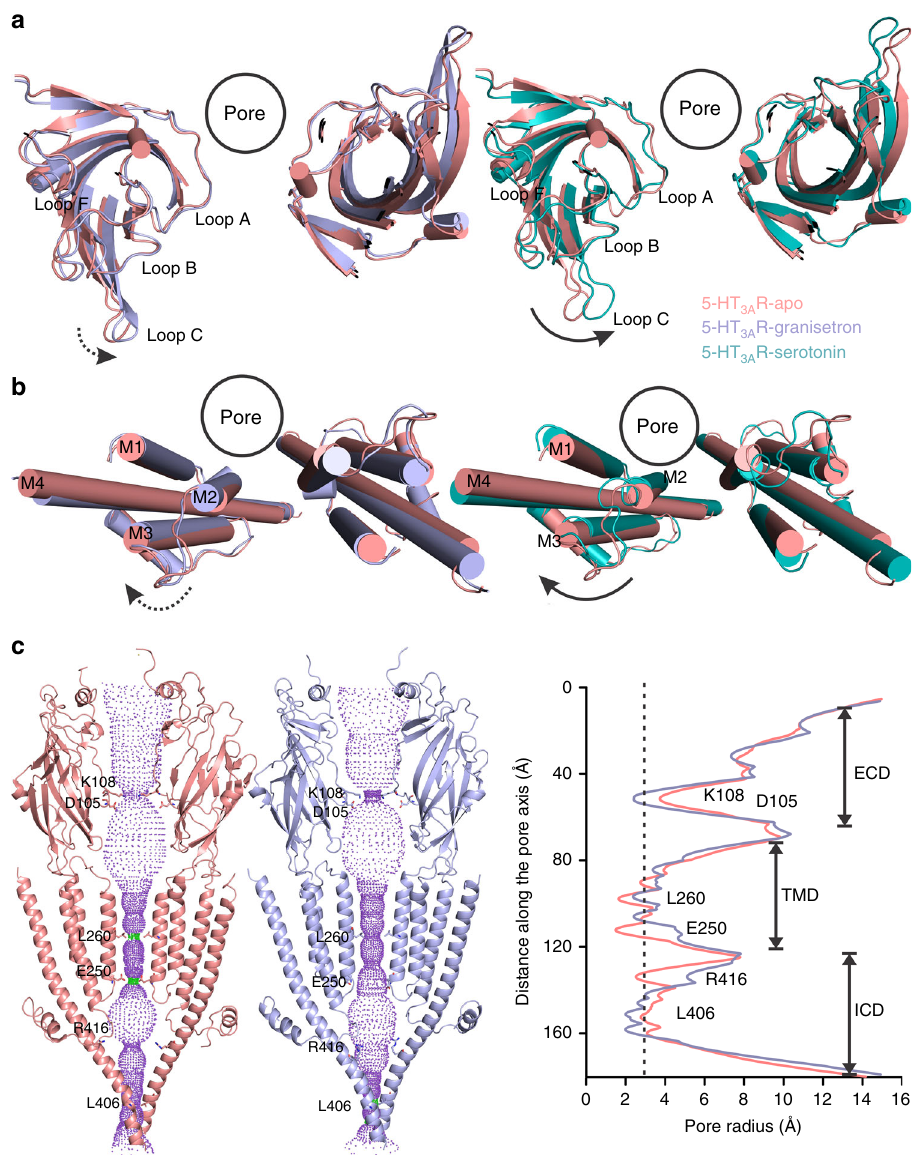
Fig. 3 Conformational differences between the apo and ligand-bound states. a An extracellular view of the extracellular domain (ECD) upon global alignment of serotonin 3A receptor-apo (5-HT 3A R-apo) structure with 5-HT 3A R-granisetron (left) and 5-HT 3A R-serotonin (right). Only ECDs from two non-adjacent subunits is shown for clarity. A counter-clockwise motion of the ECD is observed as indicated by the arrows. The serotonin-induced motion is of larger magnitude compared to that of granisetron, highlighted by the solid and dotted arrows, respectively. b A comparison of the transmembrane domains (TMDs) (viewed from the extracellular side) in 5-HT 3A R-granisetron structure (left) and 5-HT 3A R-serotonin (right) when aligned with respect to 5-HT 3A R-apo. Only two non-adjacent TMD subunits are shown for clarity. In both panels, a clockwise rotation of the TMD is observed with 5-HT 3A R-serotonin revealing a larger change. c Pathway of ion permeation of 5-HT 3A R-apo and 5-HT 3A R-granisetron generated with HOLE 54 . The cartoon representation of two subunits are shown for clarity. The locations of pore constrictions are shown as sticks. The pore radius is plotted as a function of distance along the pore axis. The dotted line indicates the approximate radius of a hydrated Na + ion, which is estimated at 2.76 Å (right) 5-HT 3A R-granisetron interaction fi ngerprints (see speci fi c inter- action types in fi gure legend) for each protomer in the complex (see results in Supplementary Fig. 8). These fi ngerprints con fi rm that binding of each granisetron molecule was mainly stabilized through hydrophobic interactions with 5-HT 3A R residues nitrogen on the piperidine rings with Thr154 and Glu209 only (Supplementary Fig. 8). Since the cryo-EM density could not discriminate between axial or equatorial positions of the N -methyl group in the bicyclic ring of granisetron (Fig. 4b), we used a metadynamics-based strategy 39 to rank the two different